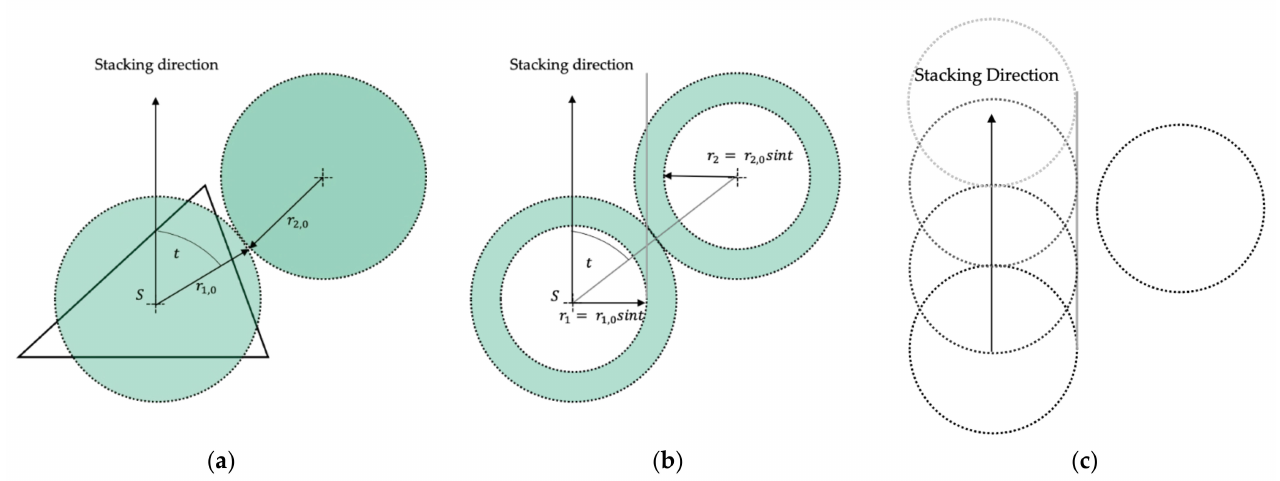
Figure 3. Determination of the effective radii with the tolerance angle; S denotes the center of gravity: ( a ) the spheres with unadjusted radii collide in angle t ; ( b ) the radii are multiplied with sin t ; so that ( c ) the spheres can pass without